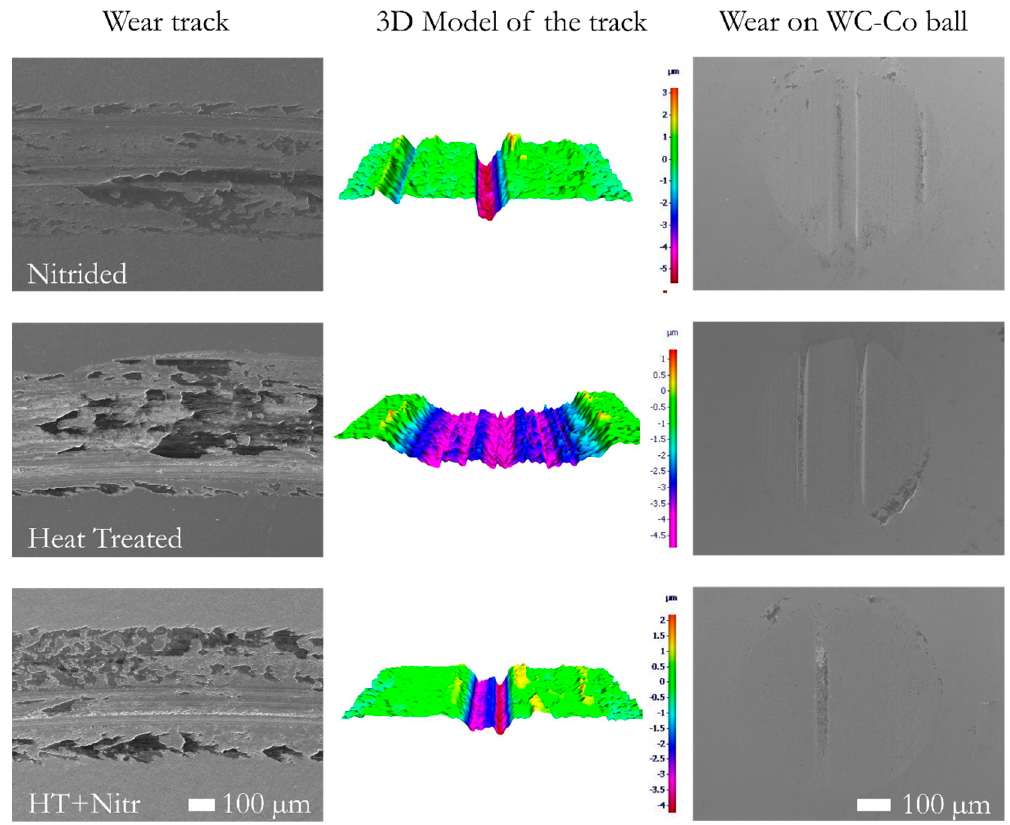
Figure 13. Wear tracks on the uncoated substrate material: SEM of the wear track (left), 3D Model (centre) and wear on the WC-Co ball (right).